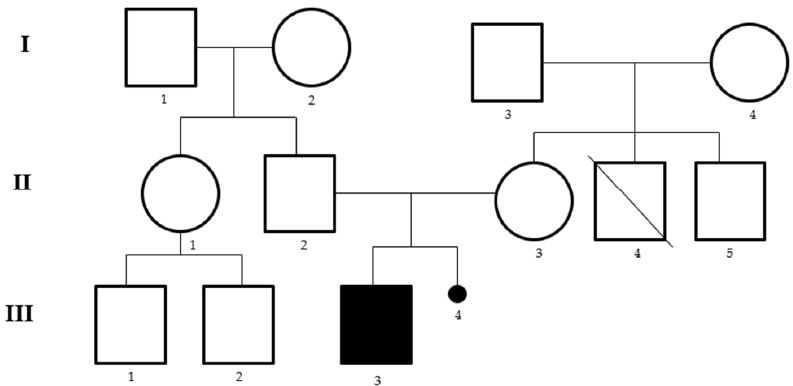
Figure 1. Pedigree of the family. I.2 grandmother ovarian cancer at 29 years, II.3 mother with pitui- tary microadenoma, II.4 uncle died of acute myocardial infarction at 31 years of age with psychiatric problems, III.3 proband, III.4 miscarriage in a previous pregnancy.